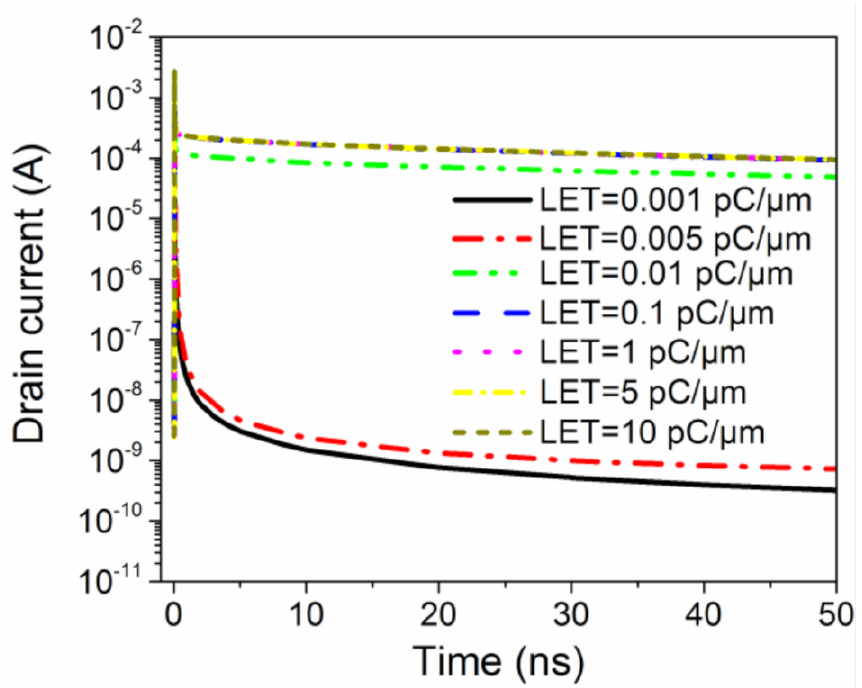
Figure 5. The transient drain currents after heavy-ion striking with different linear energy trans- fers (LETs).